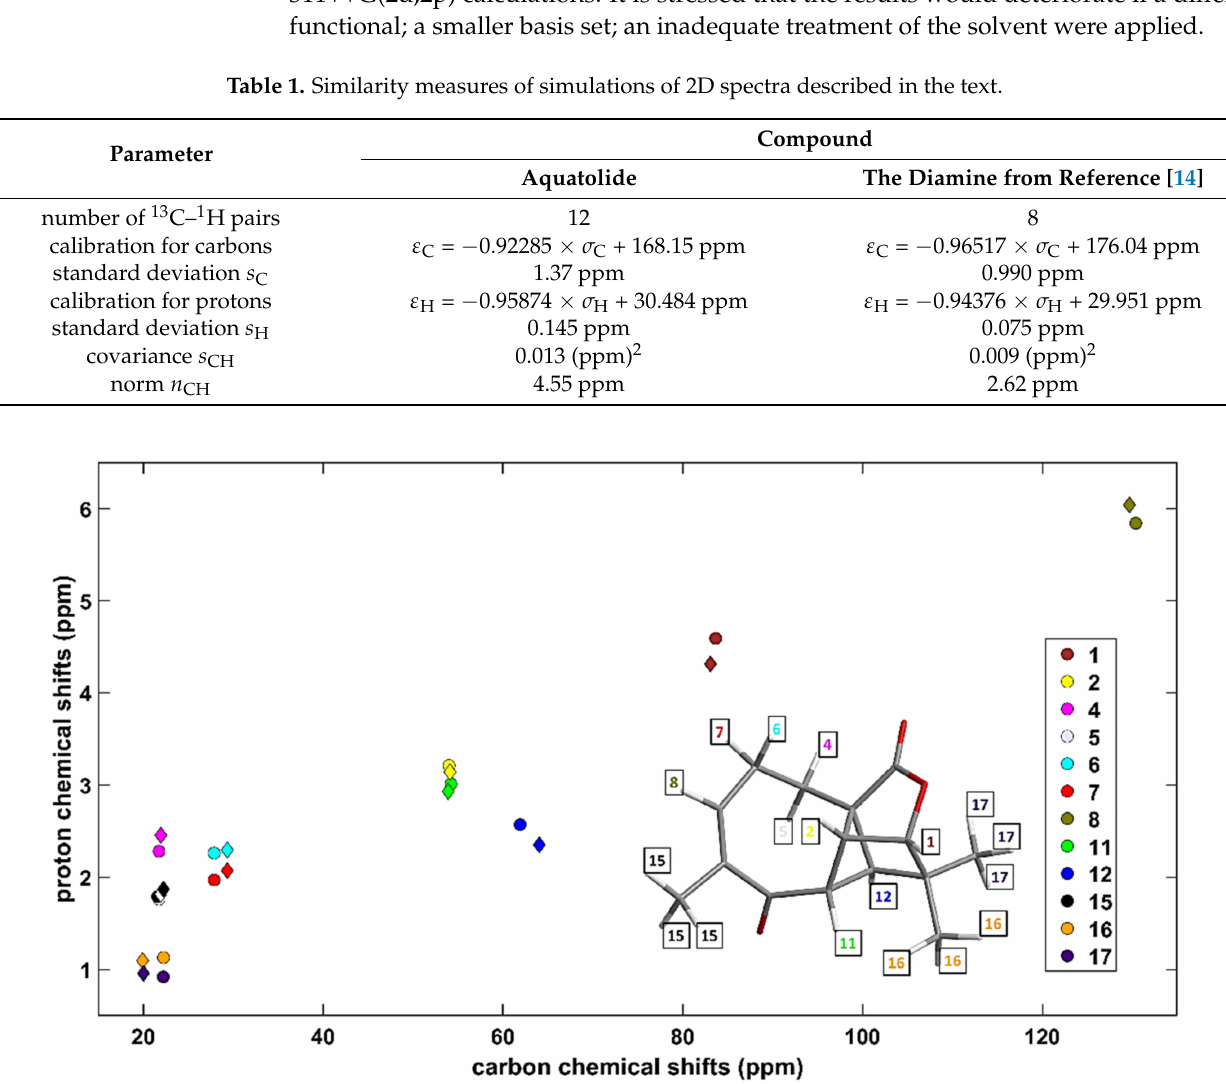
Figure 1. Comparison between theory and experiment for the { 1 H, 13 C} HETCOR spectrum of aquatolide in dimethyl sulfoxide (DMSO). The measured and the GIAO-B3LYP-PCM data (see the text for details) are marked with circles and diamonds, respectively. The HETCOR pairs are specified in the inset, while their numbering is the one used in Table 1 of reference